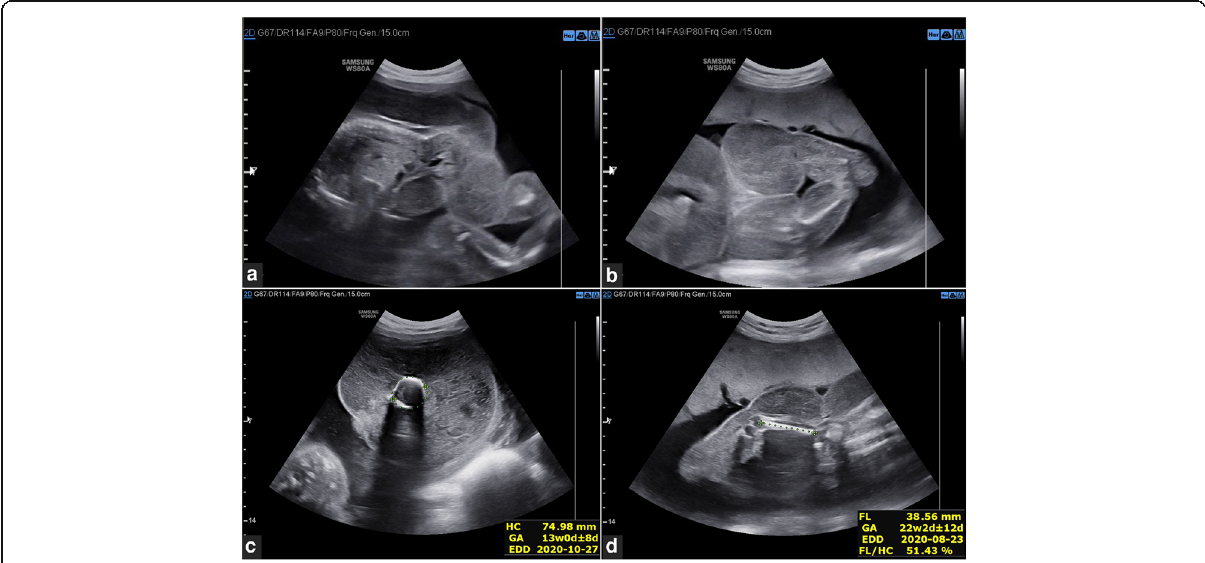
Fig. 1 a, b Dysmorphic acardiac fetus with diffuse soft tissue edema more severely in lower extremities. Marked growth discrepancy between HC and FL of acardiac twin is presented in c and d